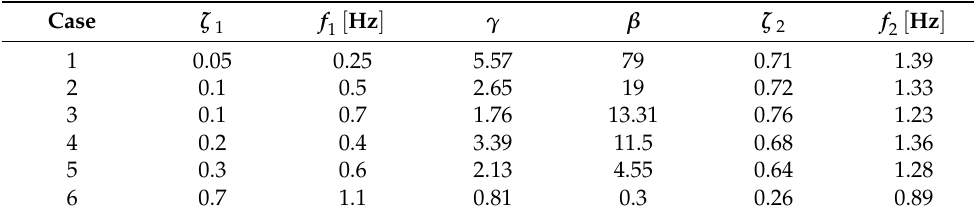
Table 2. The parameters of PWL systems.